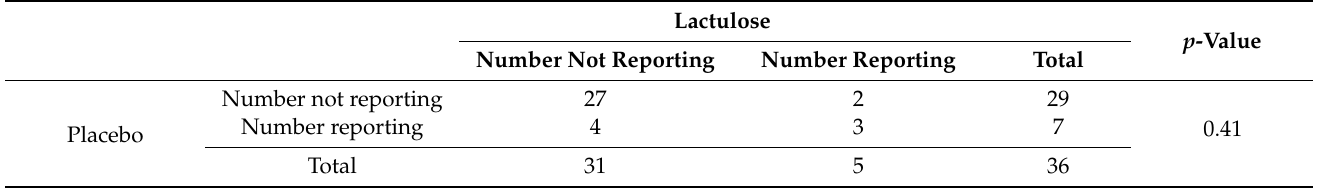
Table 7. Adverse effects in the form of gastrointestinal symptoms 1